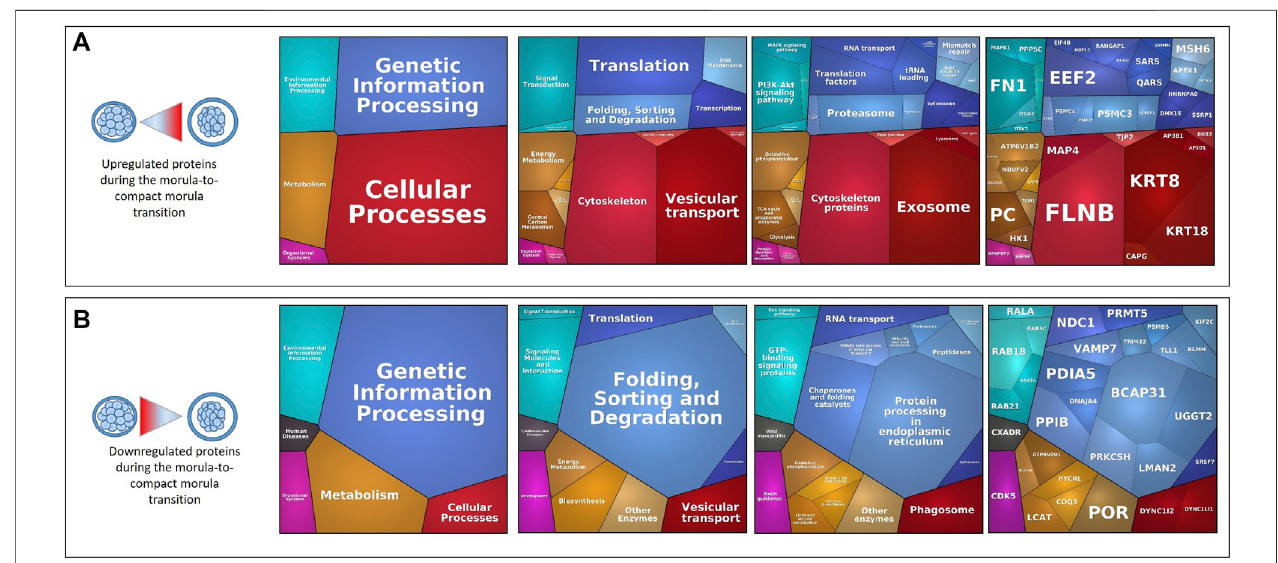
FIGURE 8 | Proteomaps of differentially abundant proteins (DAPs) during the morula-to-compact morula transition. Proteomaps were carried out using the lists of gene names of proteins increasing [ (A) , upper panels] or decreasing [ (B) , down panels] in abundance (t-test p-value ≤ 0.05; min fold-change of 2) between the morula and compact stages and based on the KEGG Pathway gene classi fi cation. Functional categories (left and middle panels) and related proteins (right panel) are shown by polygons. Areas of polygons illustrate protein abundance, weighted by protein size. Functionally related functions/proteins are arranged in common regions and coded using similar